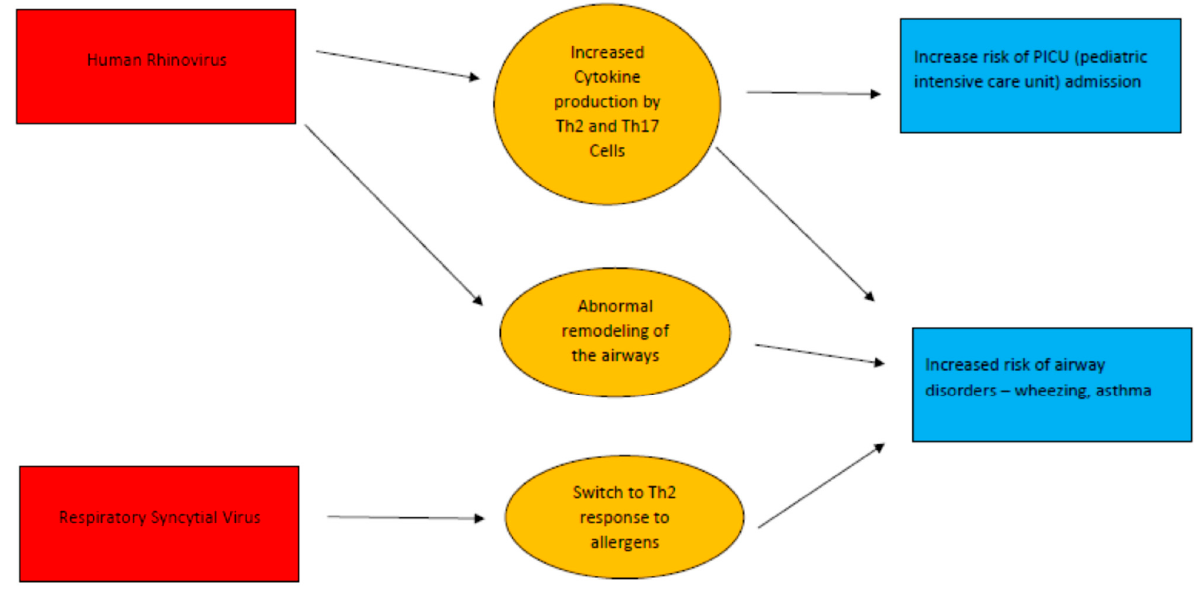
Figure 3. Long term pulmonary consequences of the respiratory tract infections in the premature infants